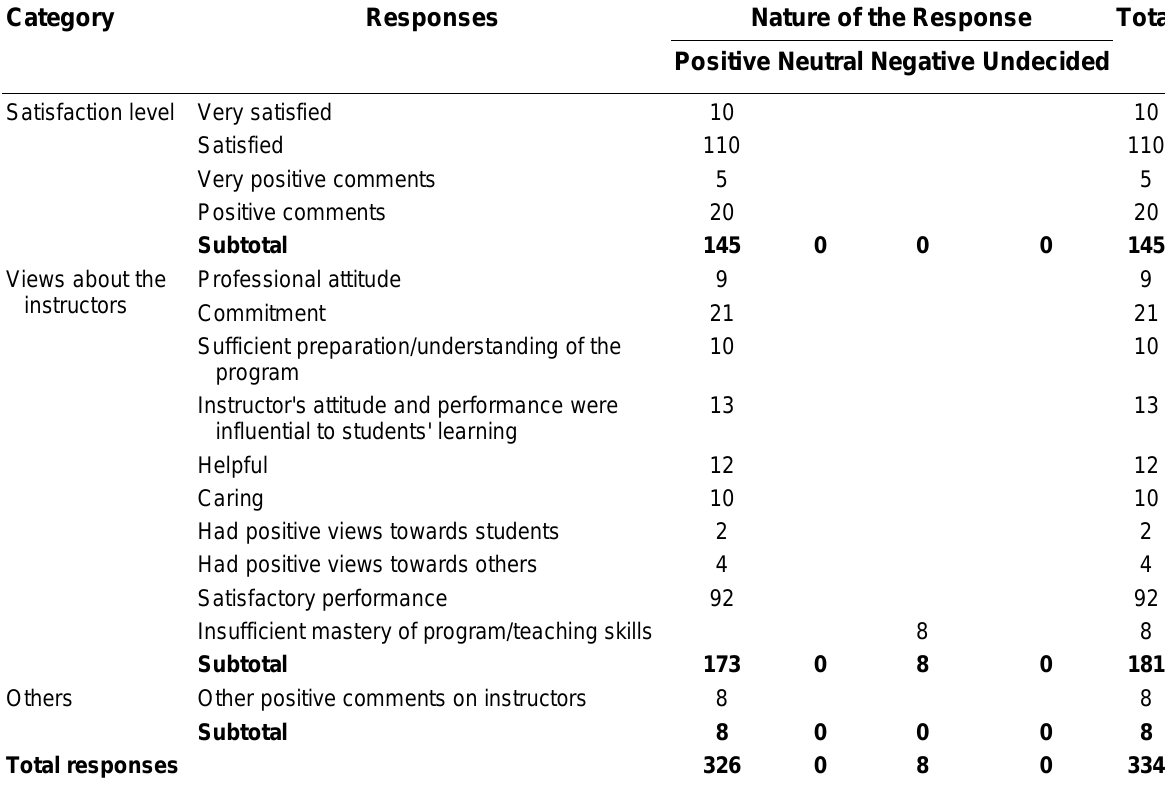
Responses on the Views towards Program